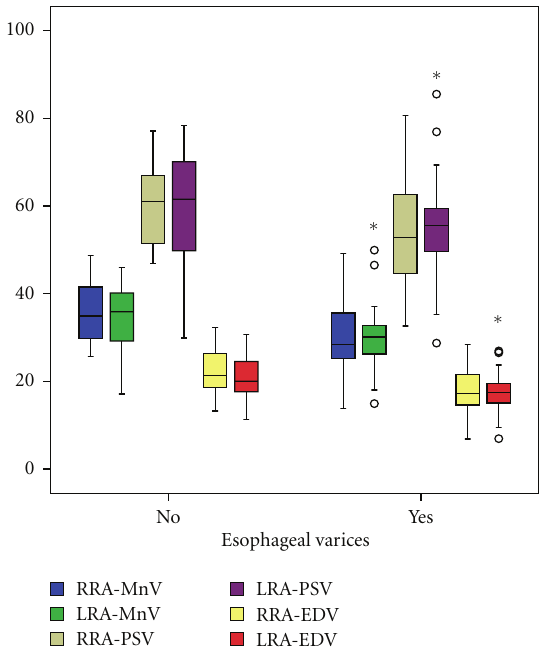
Figure 1: The values of RRA/LRA-MnV, RRA/LRA-PSV and RRA/LRA-EDV in patients with presence or absence of esophageal varices.